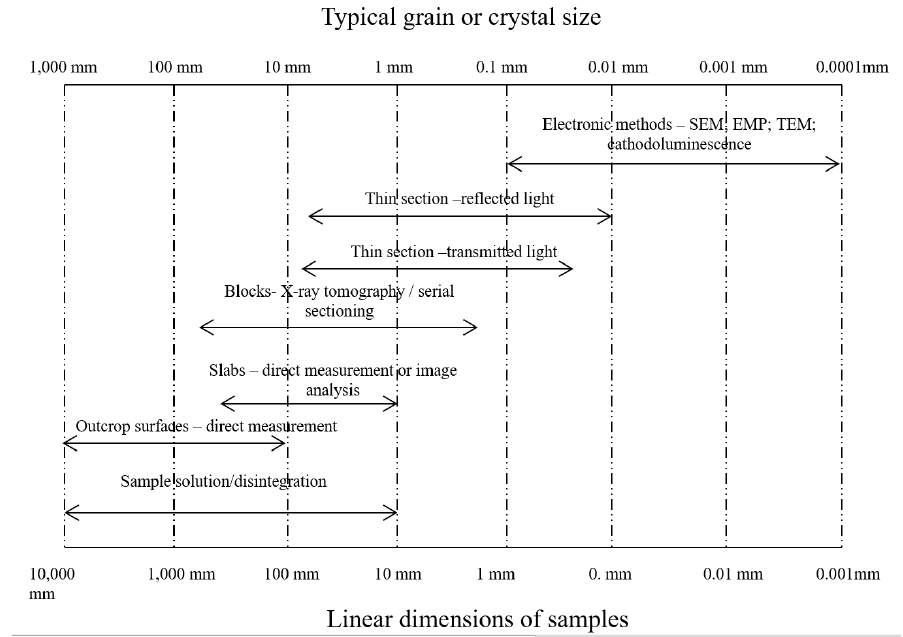
Figure 1. Measurements of crystal or grain size by analytical methods [28].